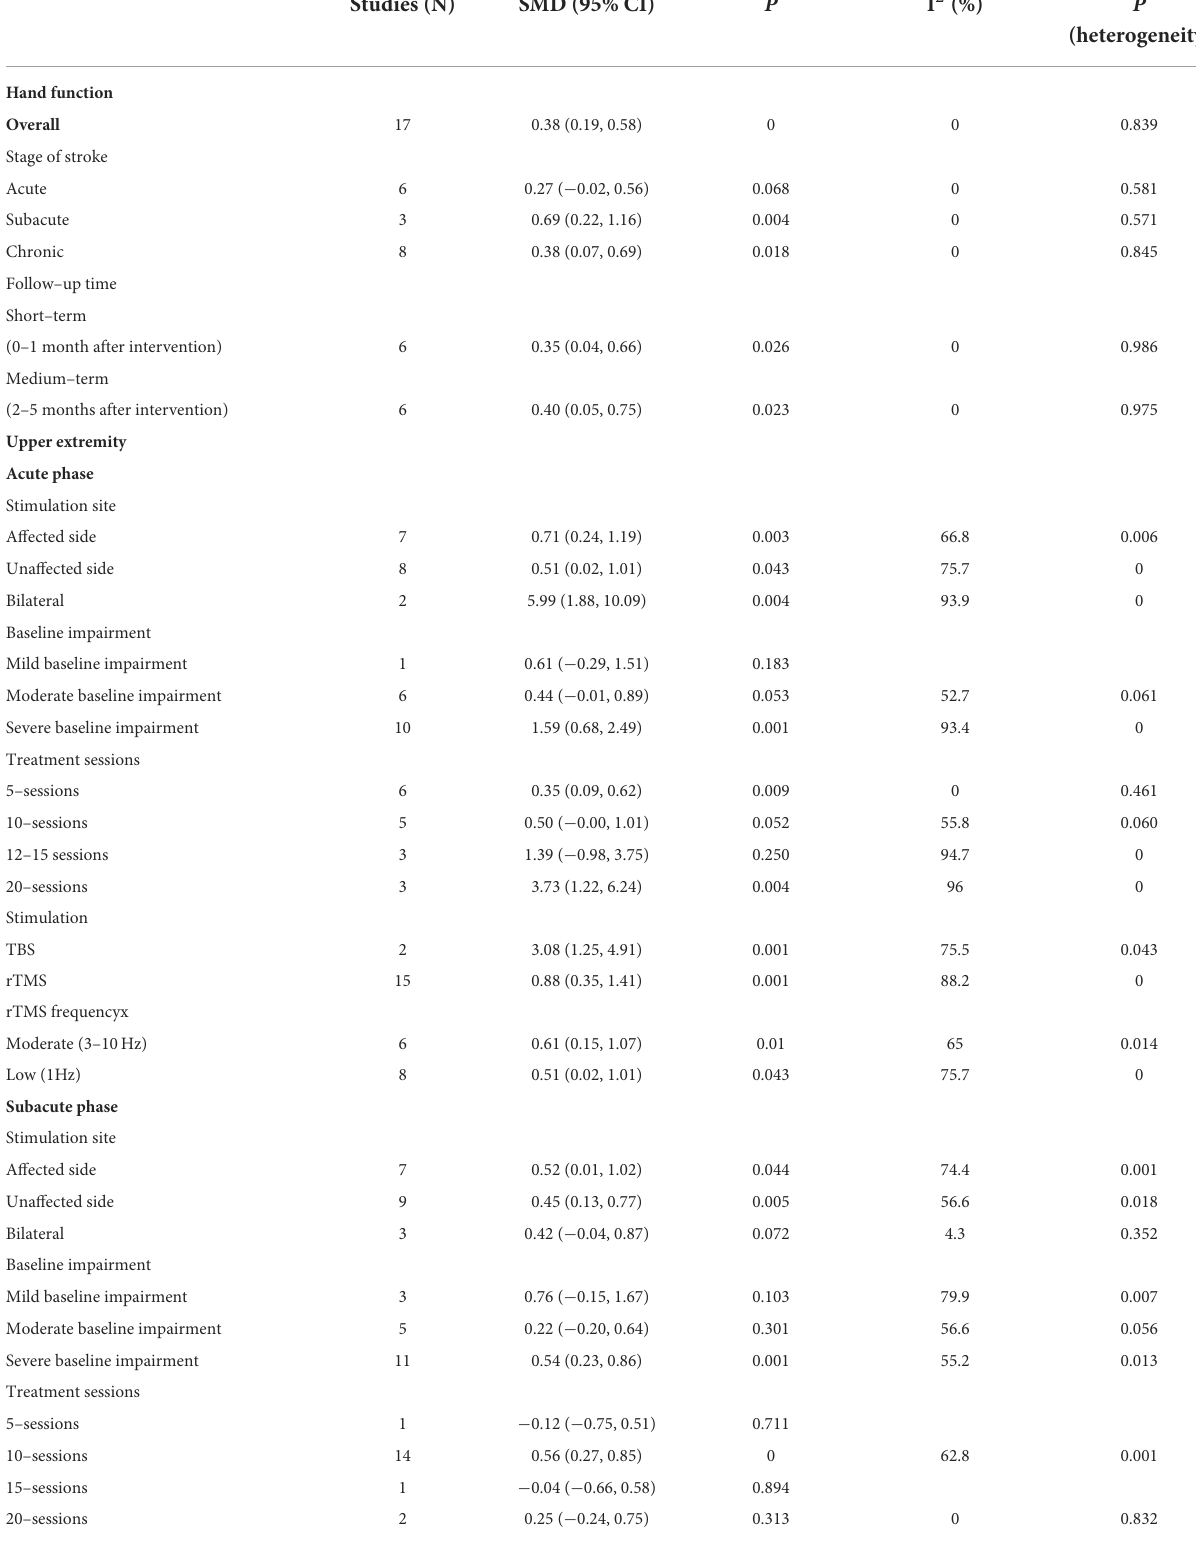
TABLE 2 Subgroup analysis: treatment vs.